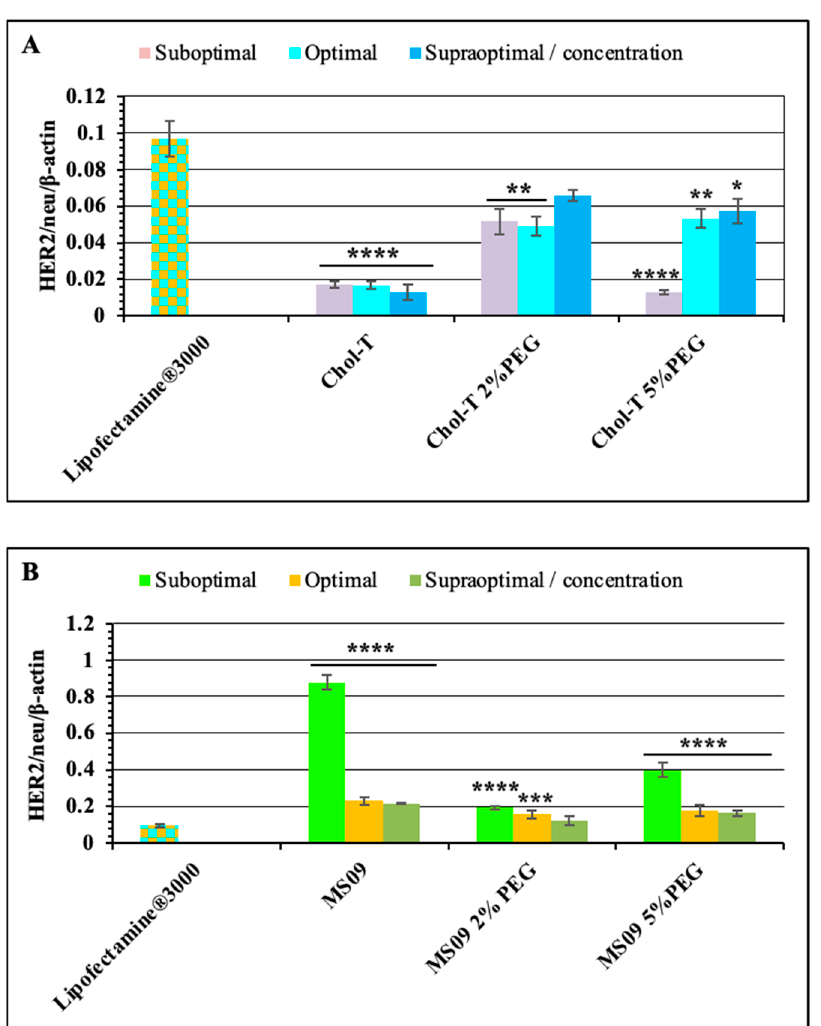
Figure 7. Comparison of HER2/neu oncogene knockdown of PEGylated and non-PEGylated ( A ) Chol-T and ( B ) MS09 lipoplexes vs. Lipofectamine ® 3000 following Western Blotting Analysis. Graphs represent the HER2/neu/ β -actin normalization ratios. Data are presented as means ± SD (n = 3). * p < 0.1, ** p < 0.01, *** p < 0.001 and **** p < 0.0001 are considered statistically significant vs. Lipofectamine ® 3000.